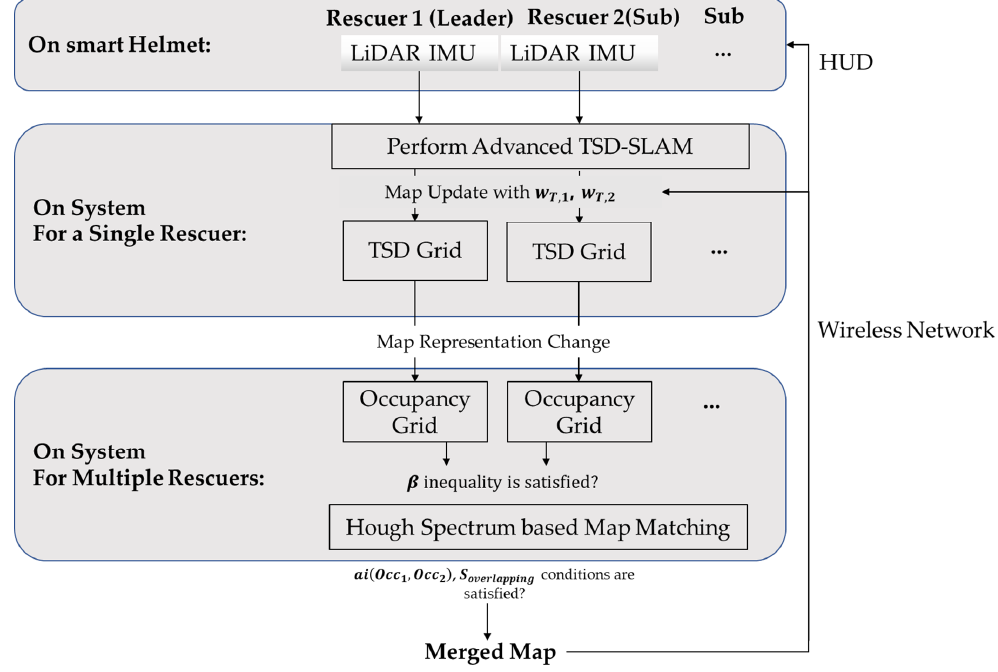
Figure 3. Proposed rescue scheme.